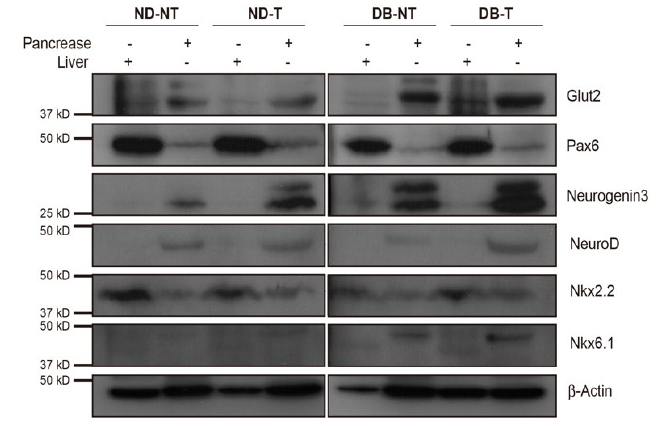
Figure 4. Hydrolyzed SF leads to improvement in the expression of pancreatic β -cell regeneration genes in the whole pancreatic tissue. Western blot analysis of the whole pancreas and liver tissue extracts with antibodies against Glut2, Pax6, neurogenin 3, Neuro D, Nkx2.2, Nkx6.1, and actin (ND-T: db/+ SF treated, ND-NT: db/+ SF non-treated, DB-T: db/db SF treated, and DB-NT: db/db SF non-treated).